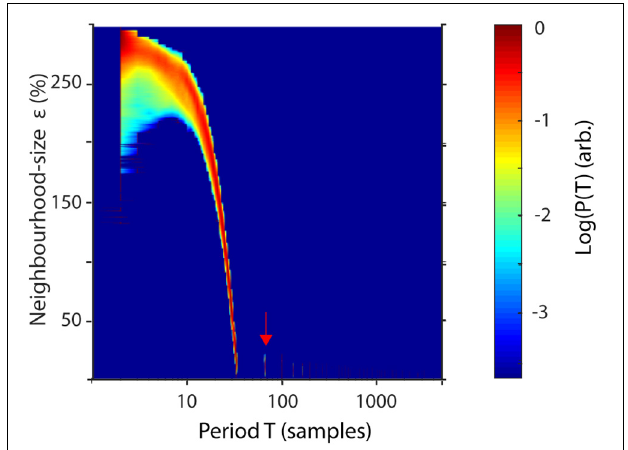
FIGURE 3 | Spatially resolved recurrence probability. The plot shows recurrence probabilities P(T) of 50 s of a 3-Hz signal (+8% STD white noise) as a function of periods T = 1–5,000 samples and increasing neighborhood sizes ε = 1–300. ε is represented in % of the standard deviation of the raw time series. The arrow indicates the noise